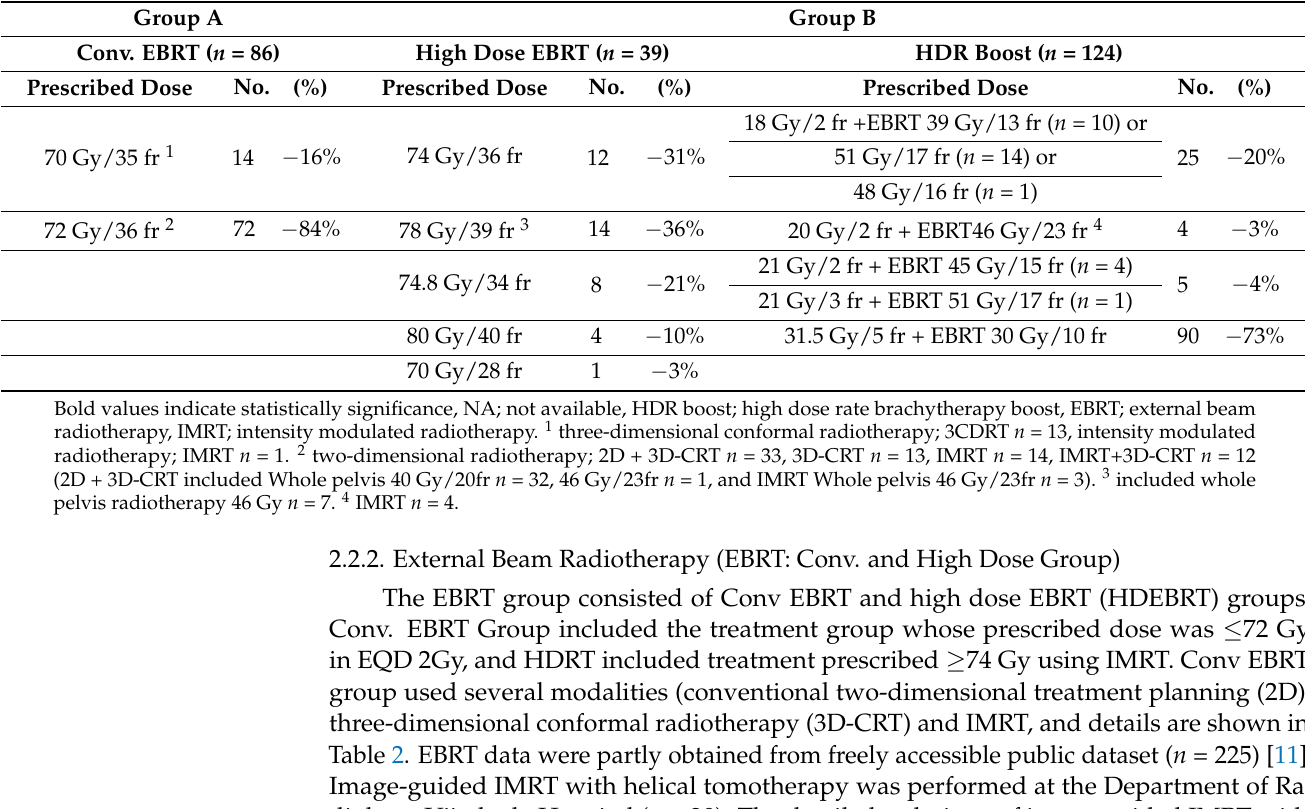
Table 2. EBRT data were partly obtained from freely accessible public dataset ( n = 225) [11]. Image-guided IMRT with helical tomotherapy was performed at the Department of Ra- diology, Ujitakeda Hospital ( n = 20). The detailed technique of image-guided IMRT with helical tomotherapy has been described elsewhere [12]. In Ujitakeda hospital, we